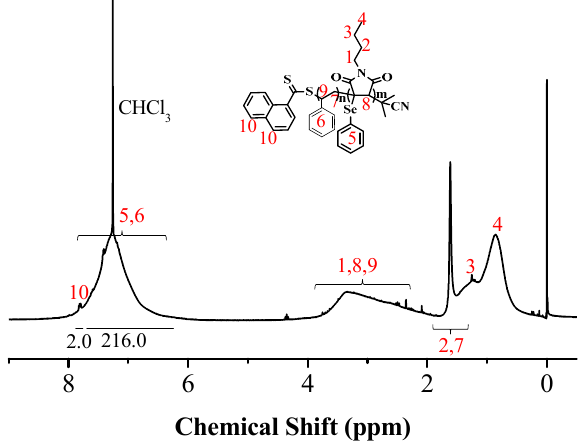
Figure 2. 1 H NMR spectrum of the RAFT copolymer in CDCl 3 .